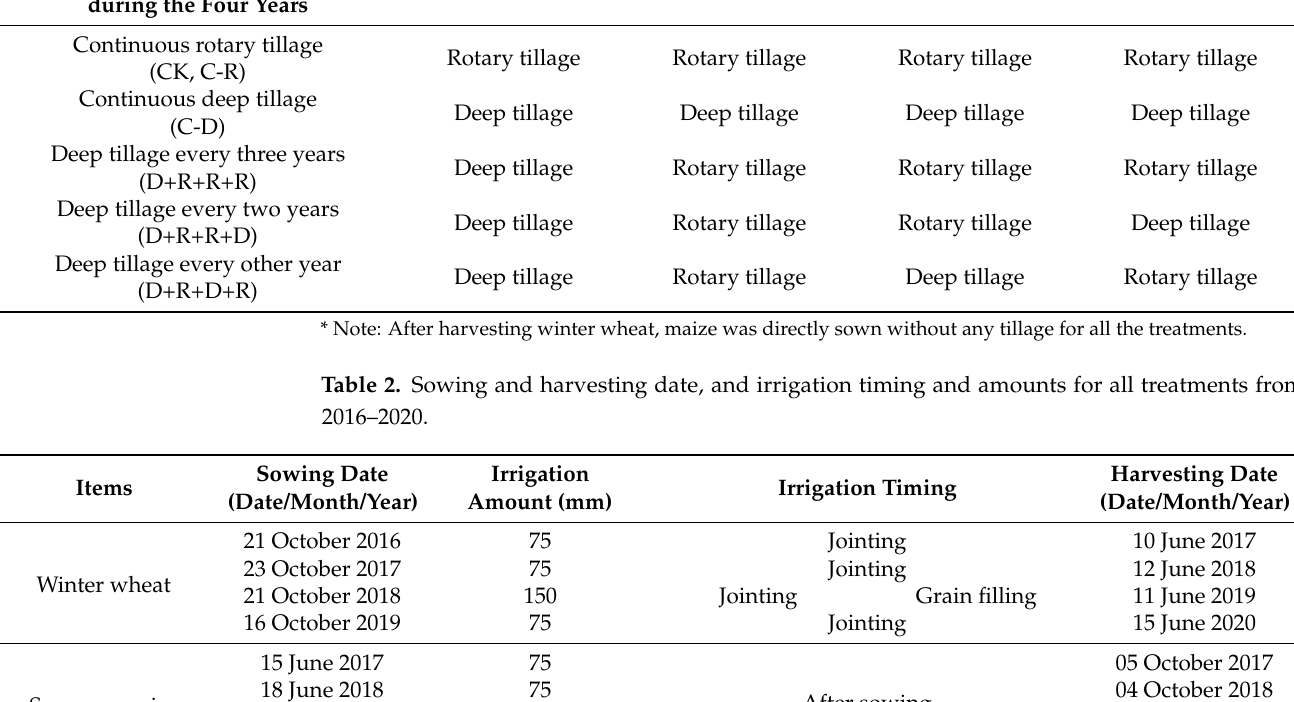
Table 1. The five tillage treatments conducted before sowing winter wheat, from 2016 to 2020 *. Treatments and Their Combinations during the Four Years